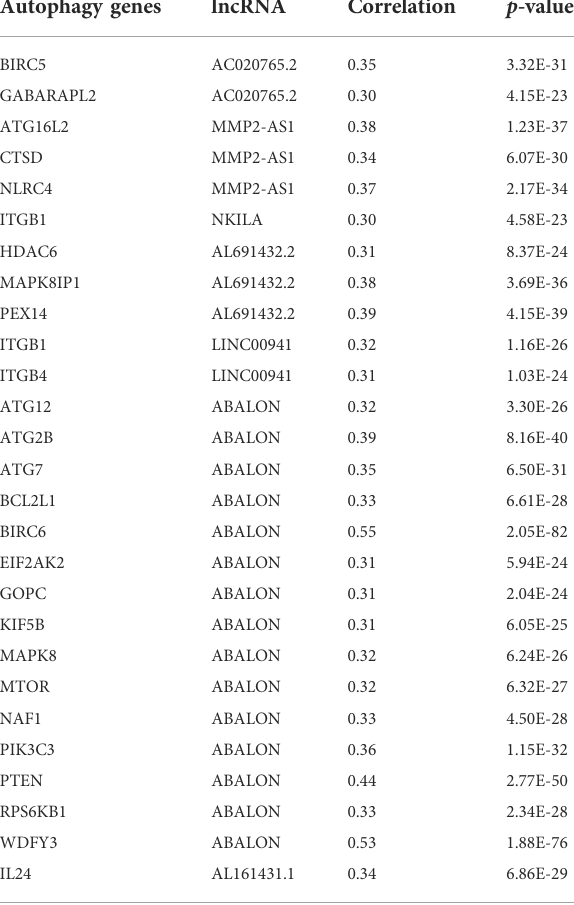
TABLE 2 Correlation between autophagy genes and lncRNAs in NSCLC. Autophagy